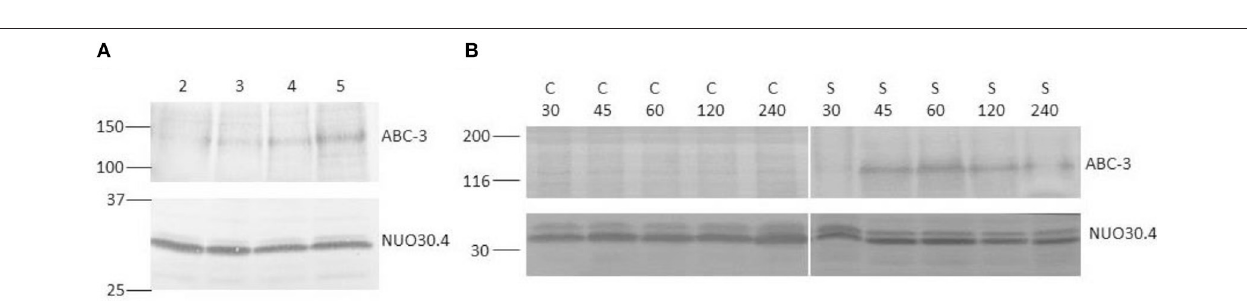
FIGURE 2 | Western blots of total protein extracts from N. crassa cells, using antiserum against the 130 kDa ABC-3 and the constitutive 30.4 kDa subunit of complex I (NUO30.4), as control for loading. (A) N. crassa was grown for the indicated times in hour and subsequently exposed to 12.5 µ M STS for 1h. (B) N. crassa was grown for 5h and subsequently incubated with 12.5 µ M STS (S) or DMSO as control (C) for the indicated times in min. Standard molecular weights (kDa) are indicated on the left of each